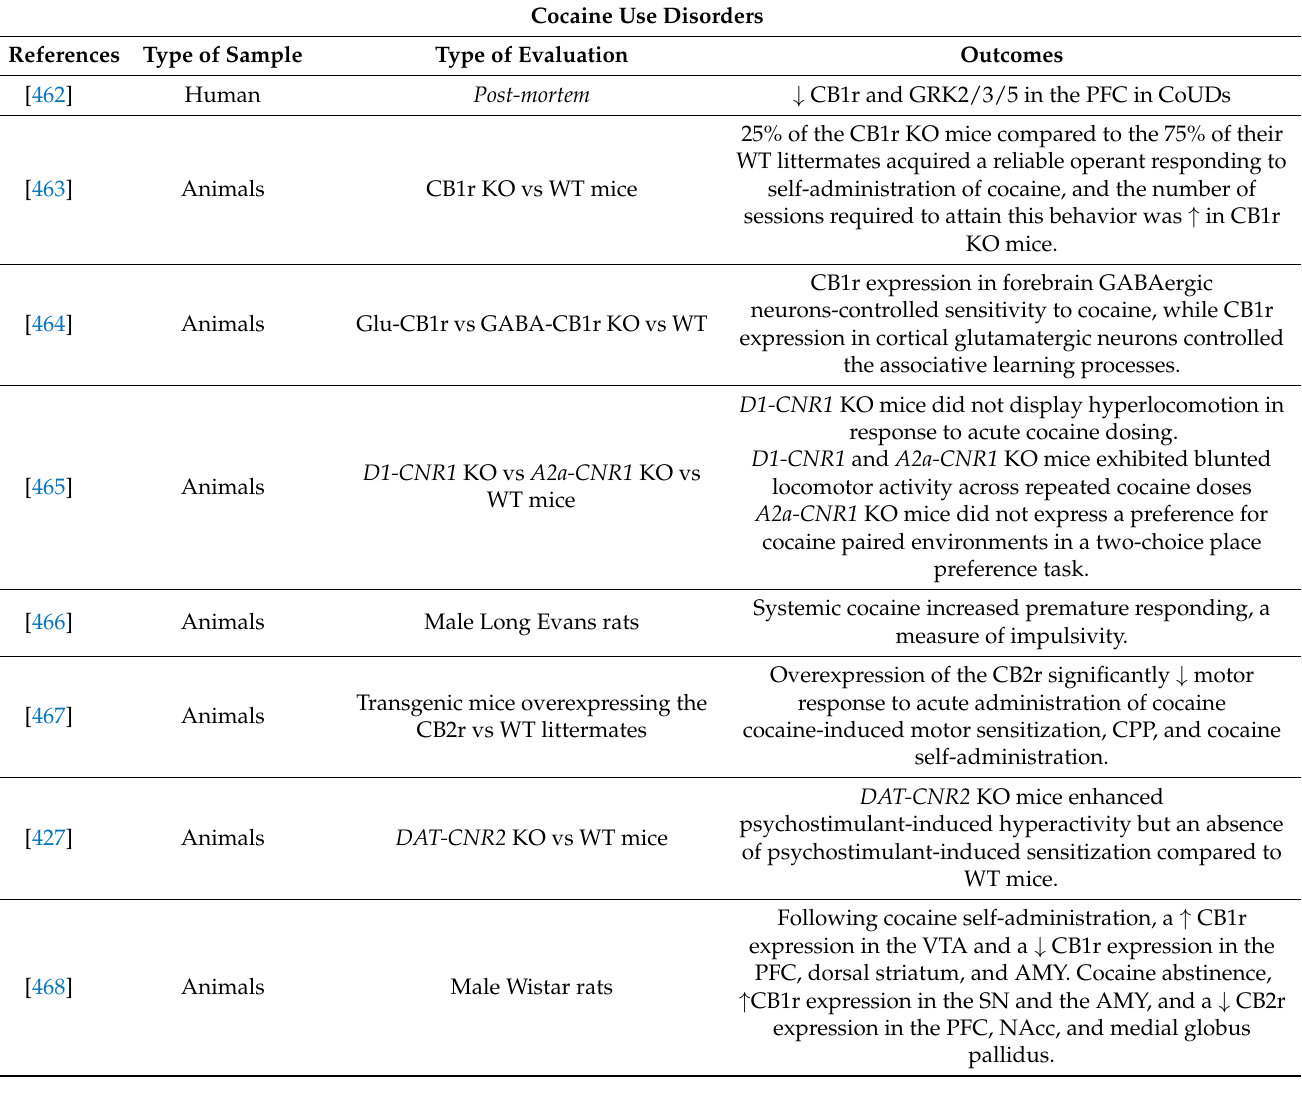
Table 4. Summary of the main findings regarding the alterations of ECS components in animals and human studies in Cocaine Use